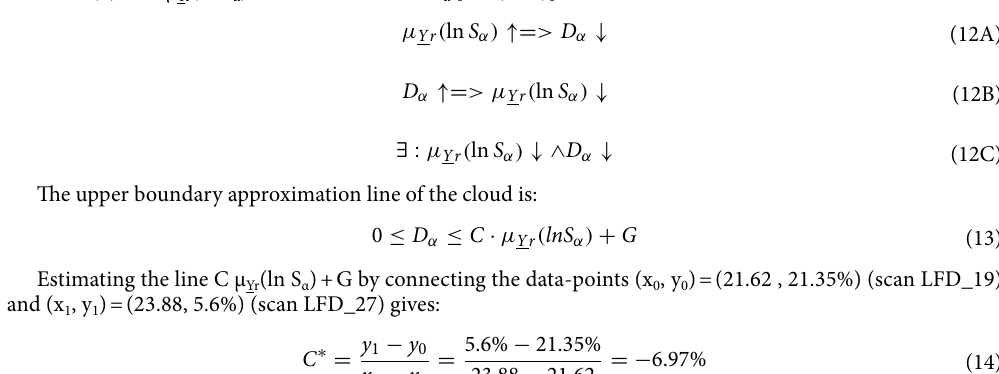
Figure 2c is the scatterplot (α = 1) of μ Yr (ln S α ) vs. μ Yr (τ α *). The distinct linear relationship with positive slope was significant in by linear regression analysis, which is a contradiction (16) to (S):